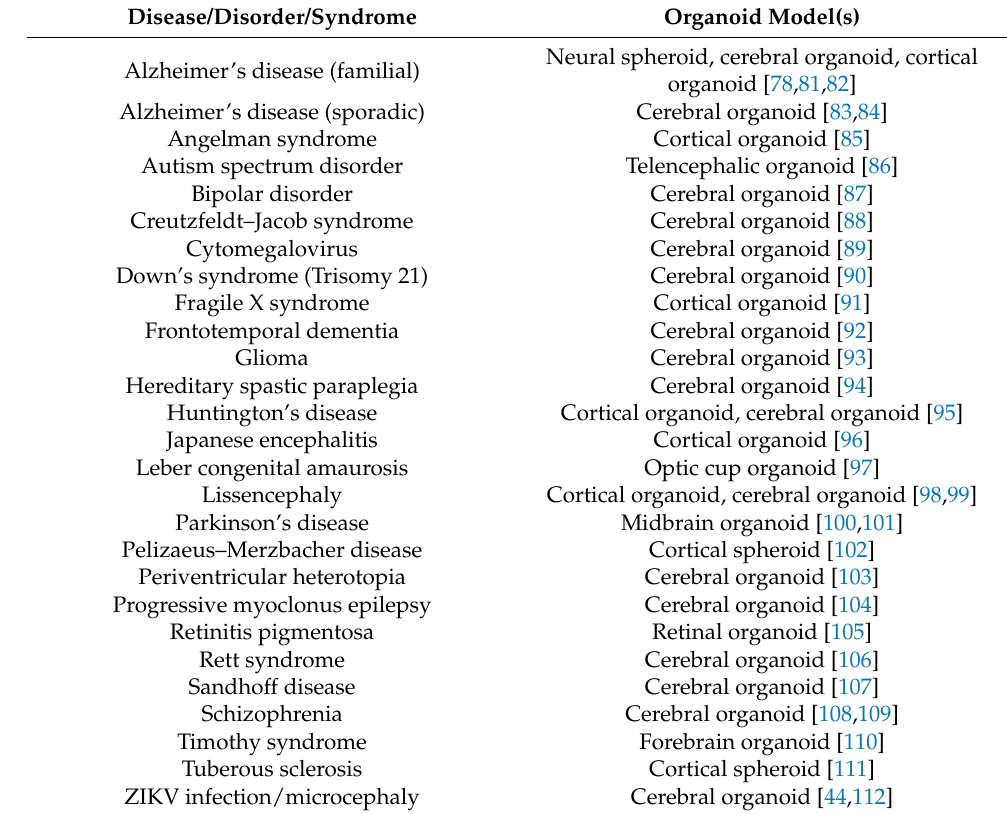
Table 1. Overview of the different diseases/disorders/syndromes that are modelled in com- plex